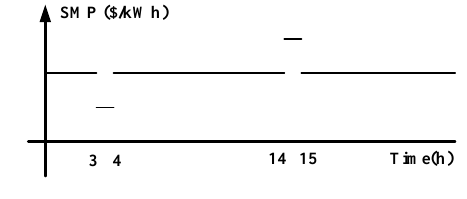
Figure 3. SMP profile for example.